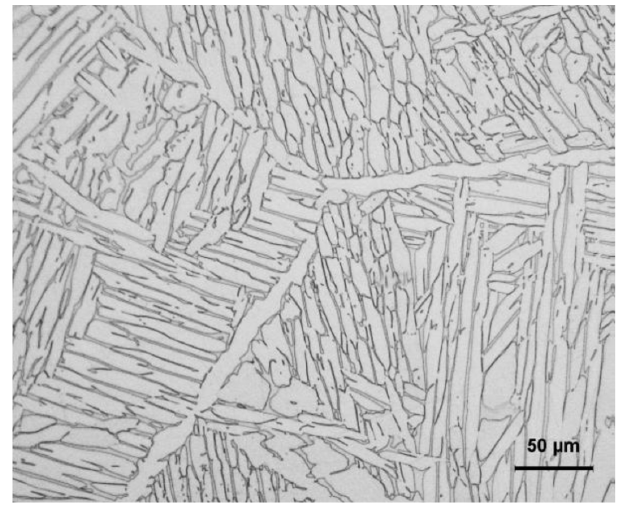
Figure 1. The microstructure of the Ti–3.3Al–1.5Zr–1.2Mo–0.6Ni alloy.